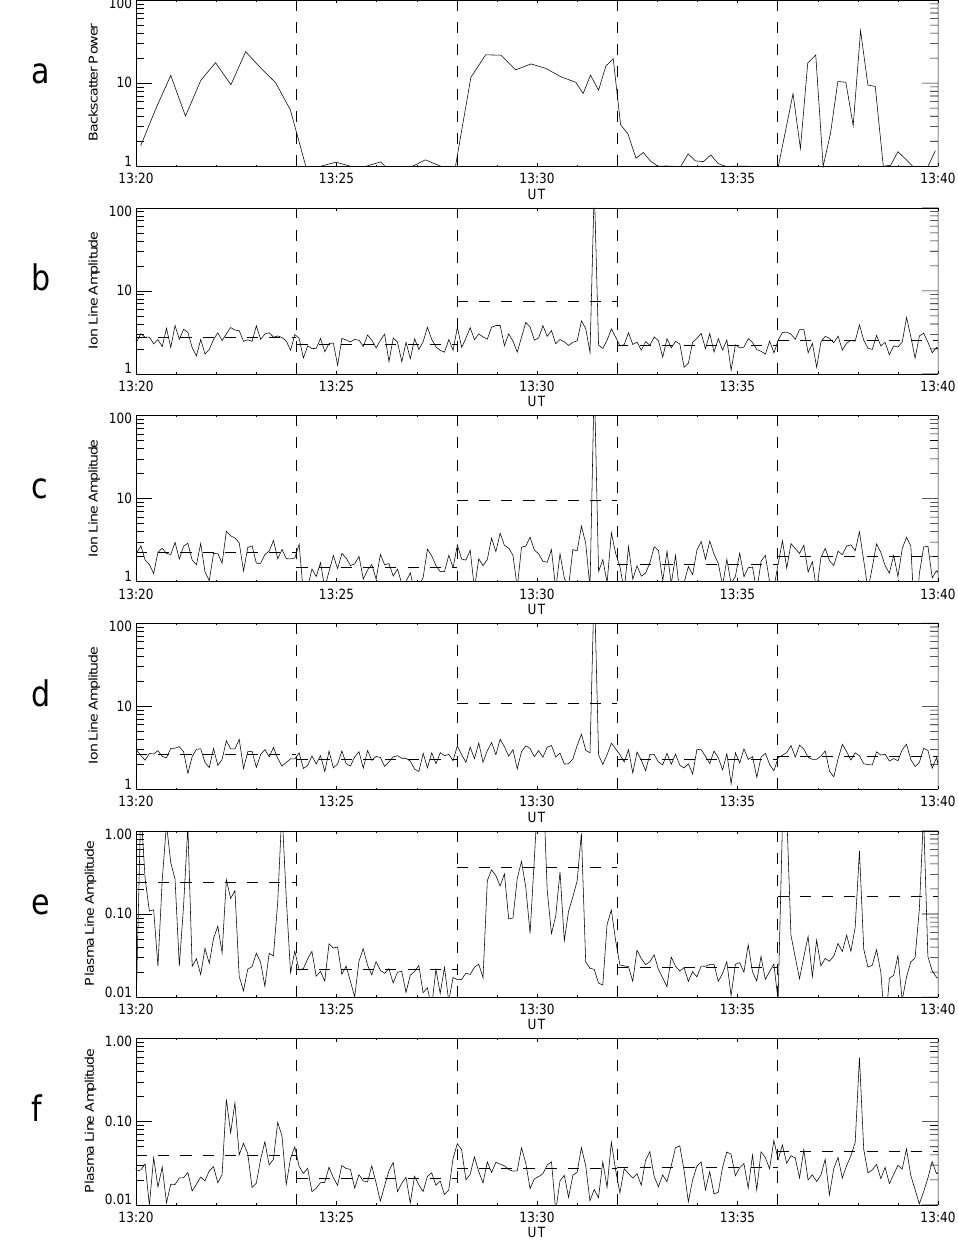
Fig. 15. Time series of amplitudes of CUTLASS Finland backscatter power (panel a ), together with ESR ion- and plasma-lines for 13:20– 13:40 UT, 28 September 2004. Panel (b) contains the upshifted ion-line; (c) , the unshifted ion-line centre frequency; (d) , the down shifted ion-line; (e) , the upshifted plasma-line and (f) , the downshifted plasma-line.